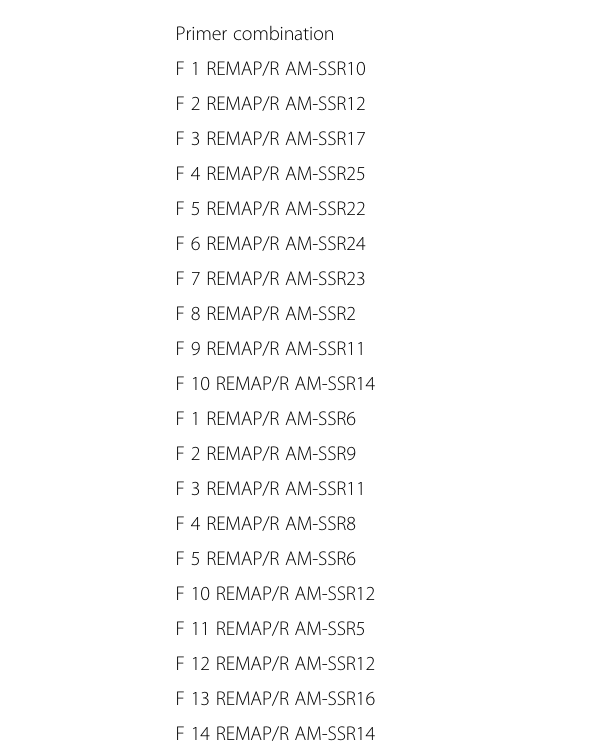
Table 2 List of SSR, LTR-IRAP, and LTR-REMAP primers sequence and its optimum annealing temperature (Continued) C: